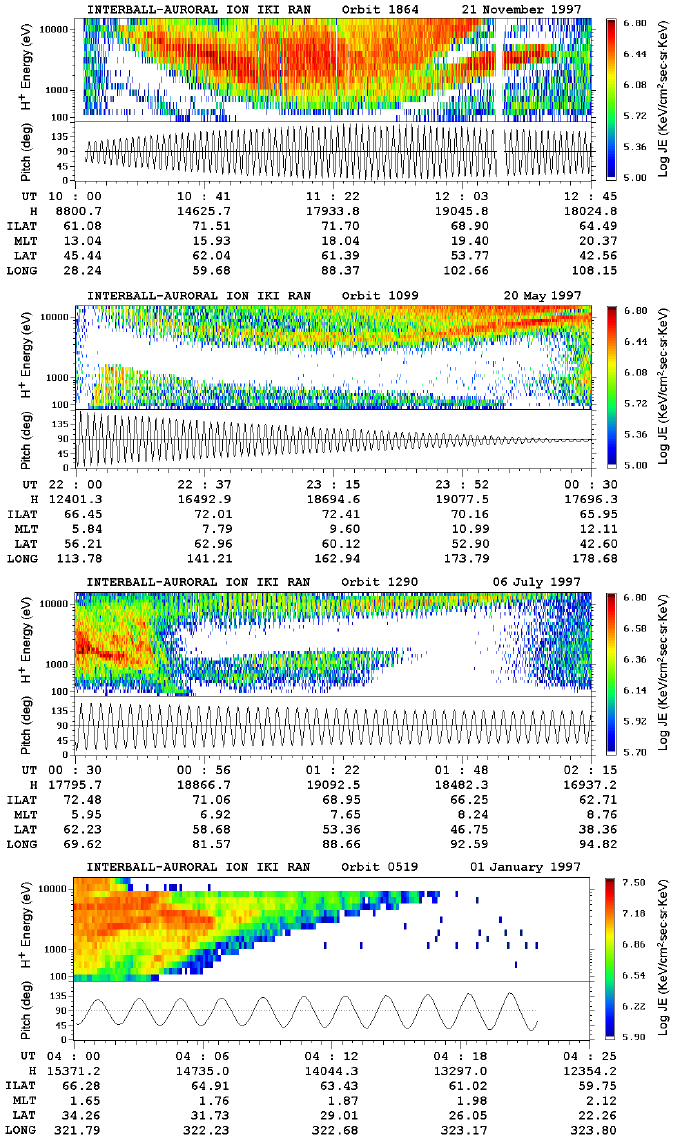
Fig. 1. Proton energy-time spectro- grams (from top to bottom) 21 Novem- ber 1997 (orbit 1864), 20–21 May 1997 (orbit 1099), 6 July 1997 (orbit 1290), 1 January 1997 (orbit 519) with ex- amples, respectively, of ISGs in the evening, dayside, morning and night- side sectors of the inner magnetosphere. At the bottom of each spectrogram the pitch angles of measured protons is shown. Energy flux is colour coded, and the colour-scale is shown on the right